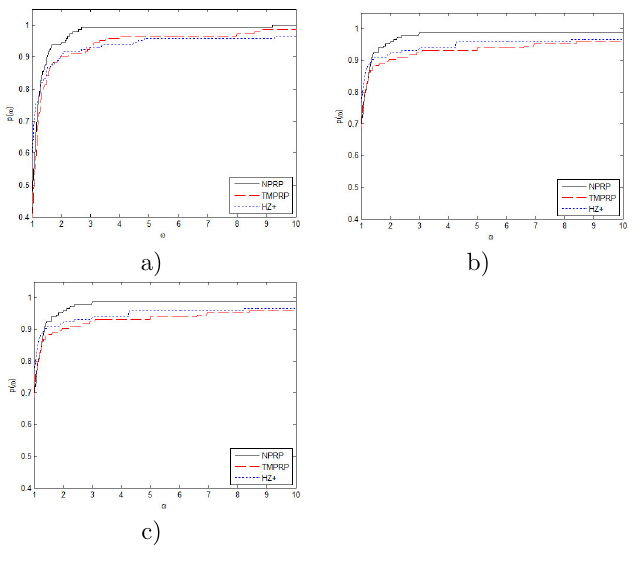
Figure 1. Performance profiles with respect to: a) the number of iteration, b) the total CPU-time, c) the total number of function and gradient